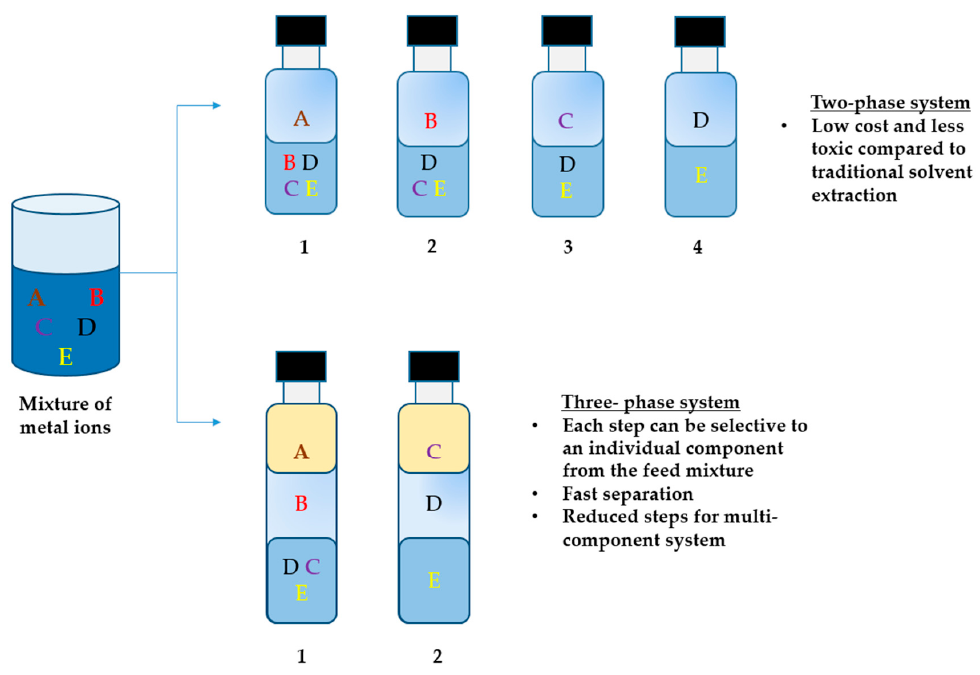
Figure 1. Schematic representations of a two- versus three-phase system for metal ion extraction. Table 1. Aqueous biphasic systems for metal ion extraction.